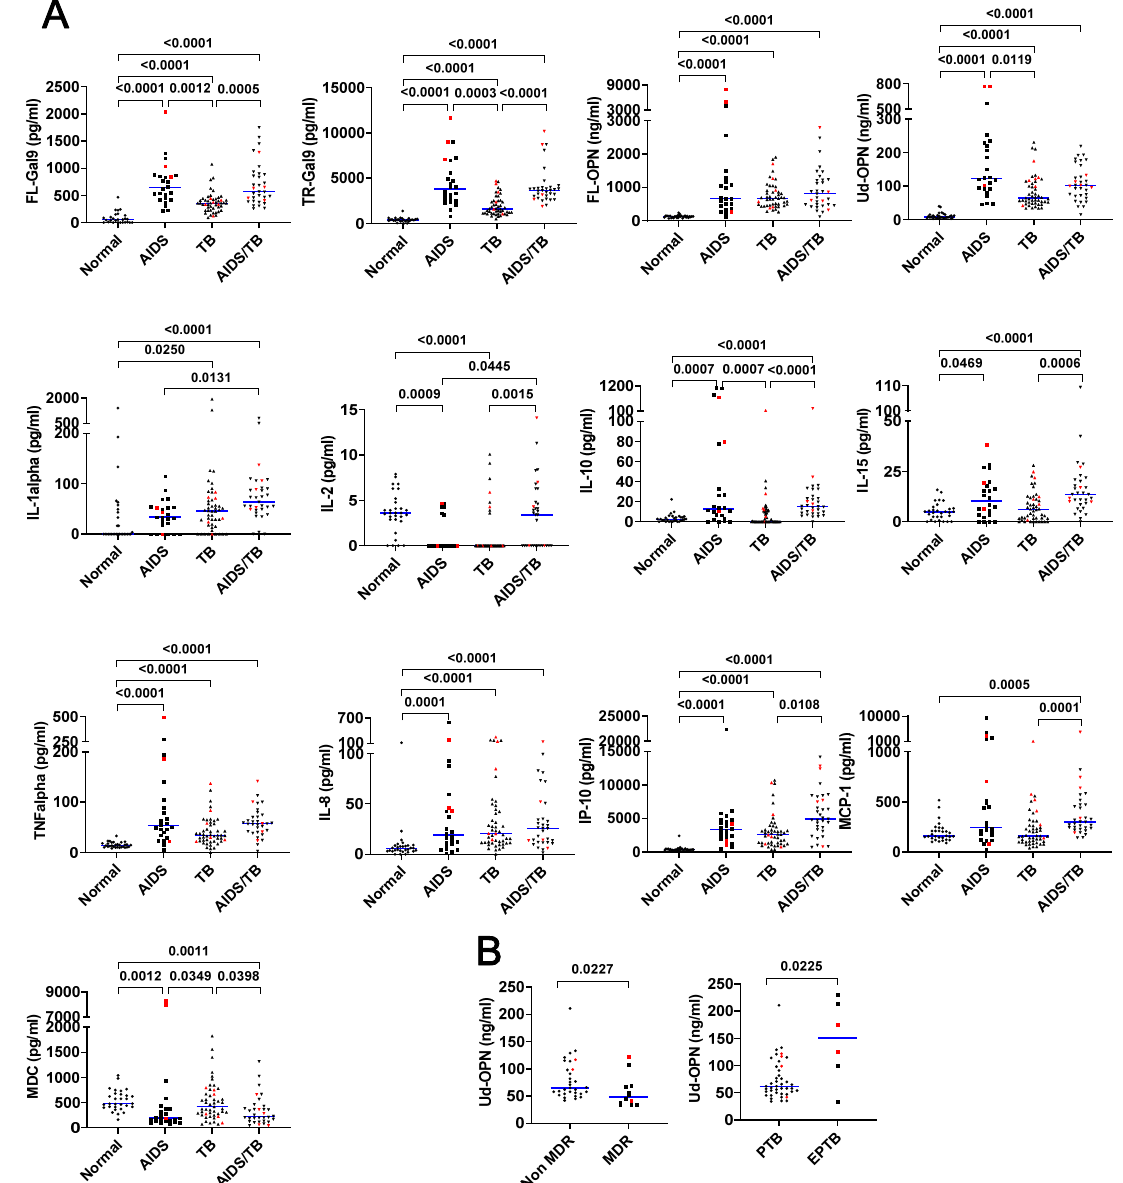
Figure 4. Amounts of plasma levels of selected molecules under different clinical conditions. ( A ) Candidates of disease markers selected by ROC analysis. ( B ) Ud-OPN differentiated subtypes of TB. Red circles represent deceased patients. When a statistically significant difference was found between the groups, the p -value was shown on the connecting line between the groups.